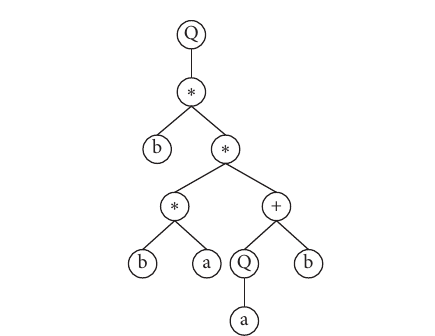
Figure 2: Typical tree structure of GP with varied string codes to allow for unaltered adaptation and evolution